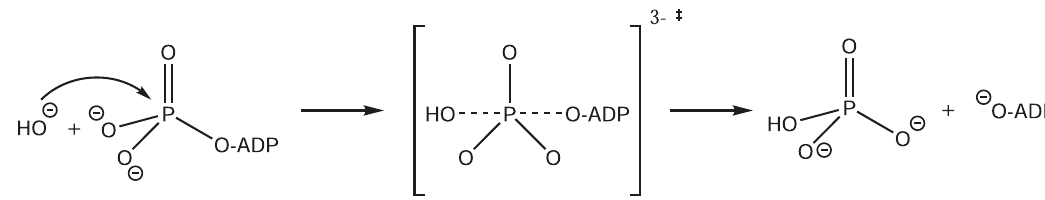
Fig. 1 Sketch of the associative ATP hydrolysis mechanism with a trigonal-bipyramidal transition state. ‡ indicates the transition